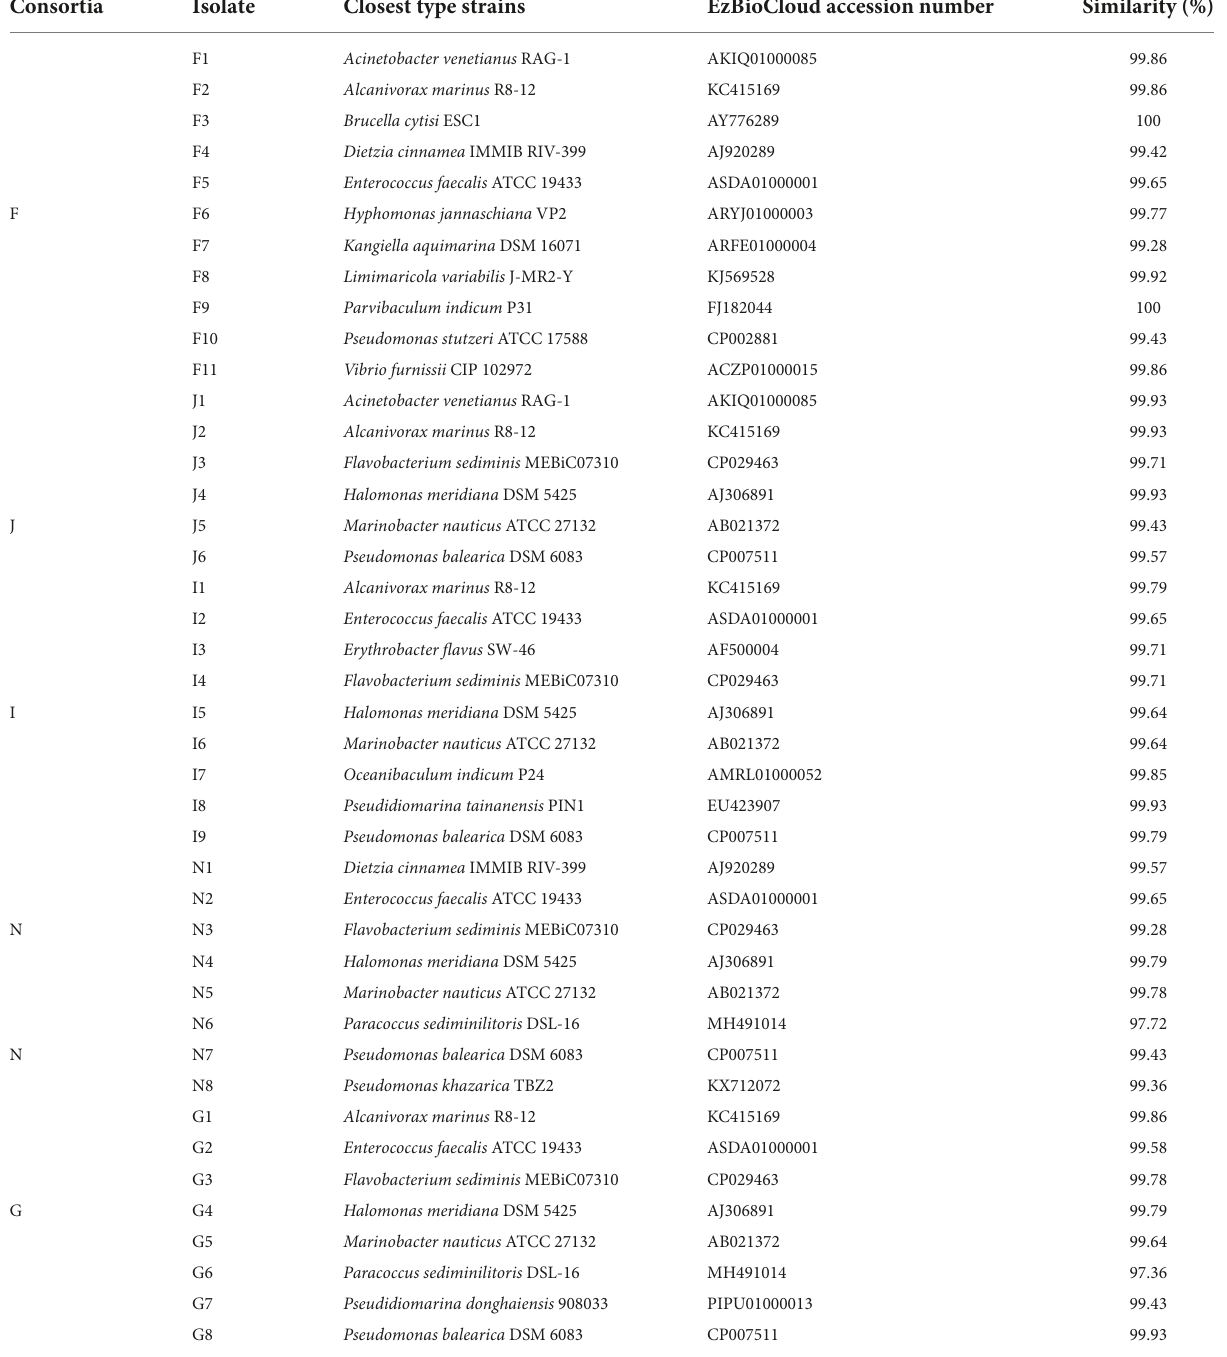
TABLE 1 Taxonomic identification of bacterial isolates recovered from the five oil-degrading consortia of F, J, I, N, and G derived from five surface sediments. Consortia Isolate Closest type strains EzBioCloud accession number Similarity